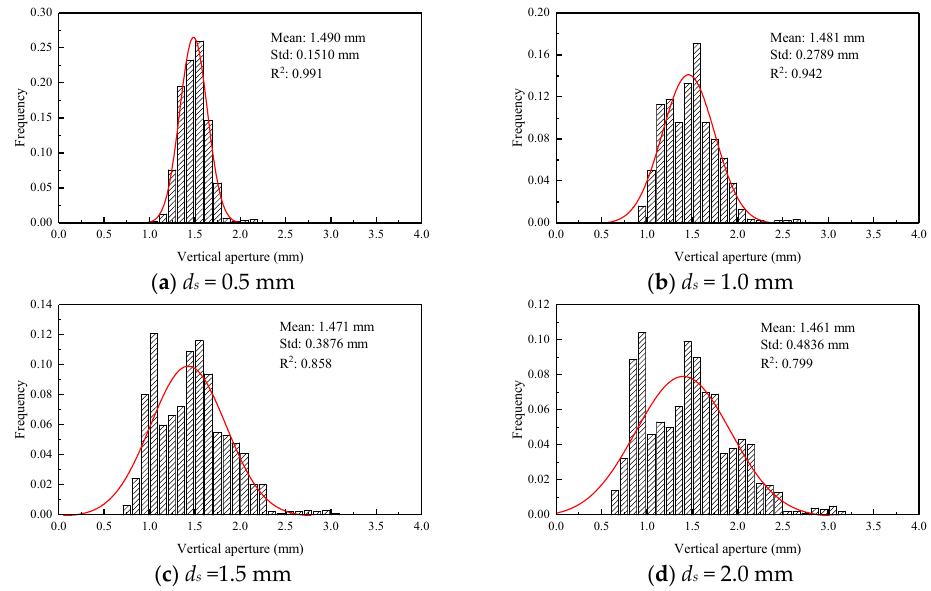
Figure 5. Gaussian distribution and vertical apertures for different shear displacements when JRC = 13.51.